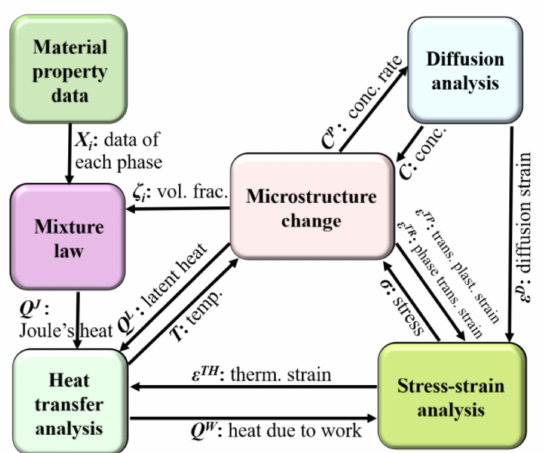
Figure 1. Structure of the heat treatment simulation system and flow of